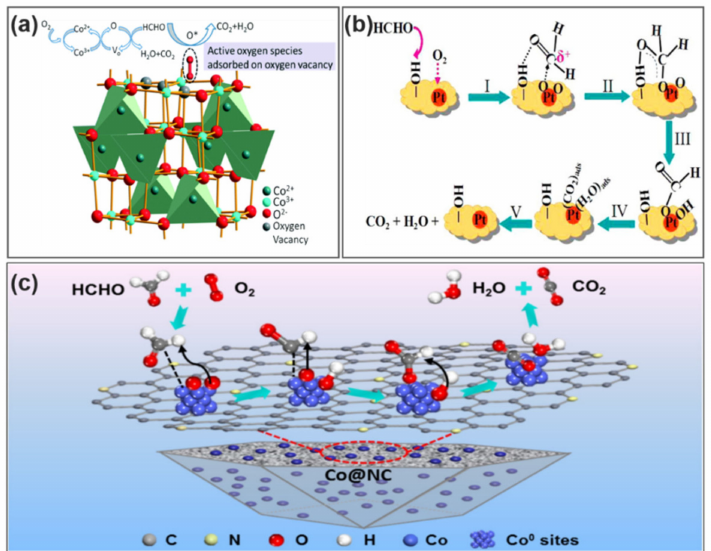
Figure 7. ( a ) Reaction mechanism of HCHO oxidation over Co 3 O 4 with surface oxygen vacancies. Reprinted with permission from reference [196]. ( b ) Reaction pathway for complete oxidation of HCHO over the Pt/Fh. Reprinted with permission from reference [197]. ( c ) Schematic illustration and reaction pathway of catalytic-oxidation of HCHO on the Co@NC catalyst at room temperature. Reprinted with permission from reference